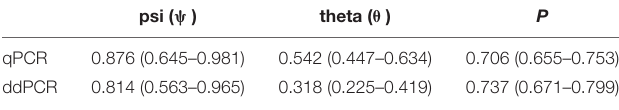
TABLE 3 | The estimated likelihood of occurrence at the location ( ψ ), in the water sample ( θ ) or PCR replicate ( p ) for qPCR and ddPCR using fixed parameters.